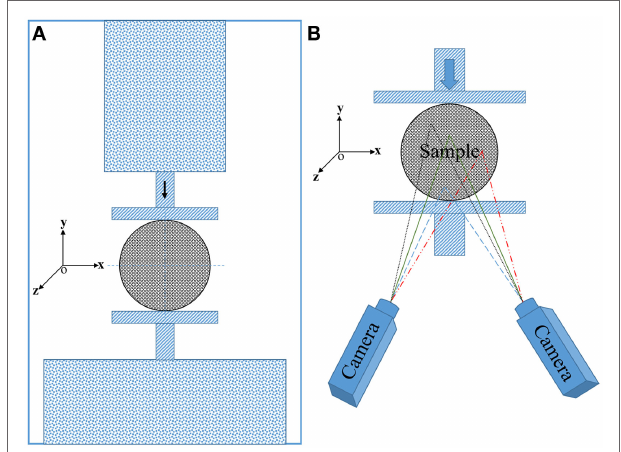
FIGURE 3 | Schematic of diametrically loaded cylinder and location of the cameras .